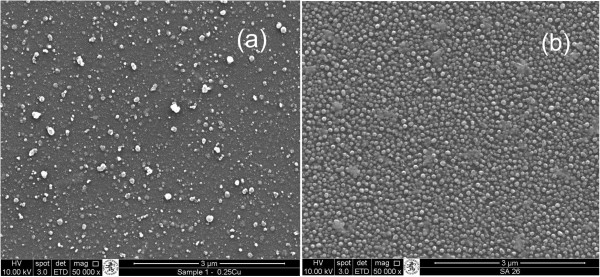
SEM analysis of CuO-SiO2 coated glass. (a) coating 1 (b) Coating 2.